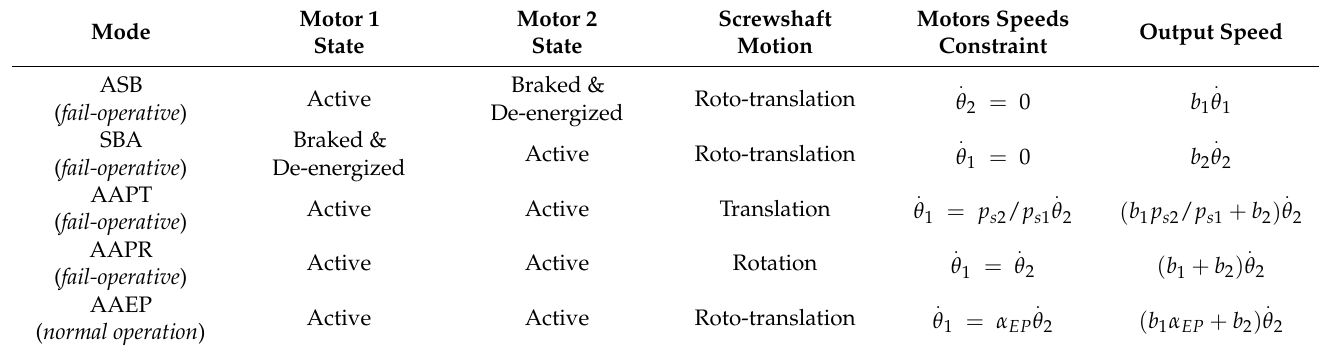
Table 1. Fault-tolerant EMA operative